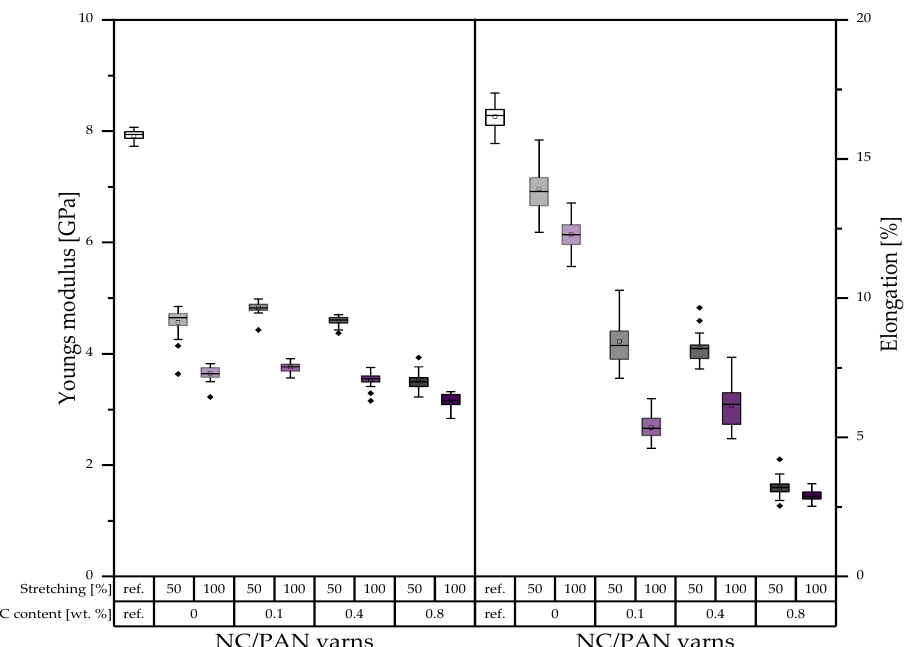
Figure 9. Young ’ s modulus and elongation of the developed porous PAN/NC yarns (in the boxes: sorted values between 25% and 75%; between the whiskers: values within 1.5 · IQR; central line: median; square: mean; and rhombus: outlier).